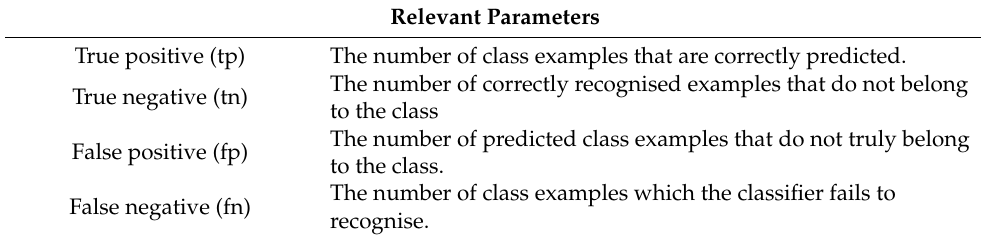
Figure 9. Confusion matrix of n classes ( n = 12 for SR and 22 for IHIL) considering the class C i , where 1 ≤ i ≤ n . Table 4. Relevant parameters used in confusion matrix-based performance metrics.